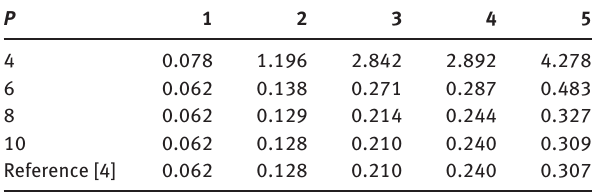
Table 1: Convergence and comparison of the first five frequency parameters Ω of the clamped isotropic circular plate.